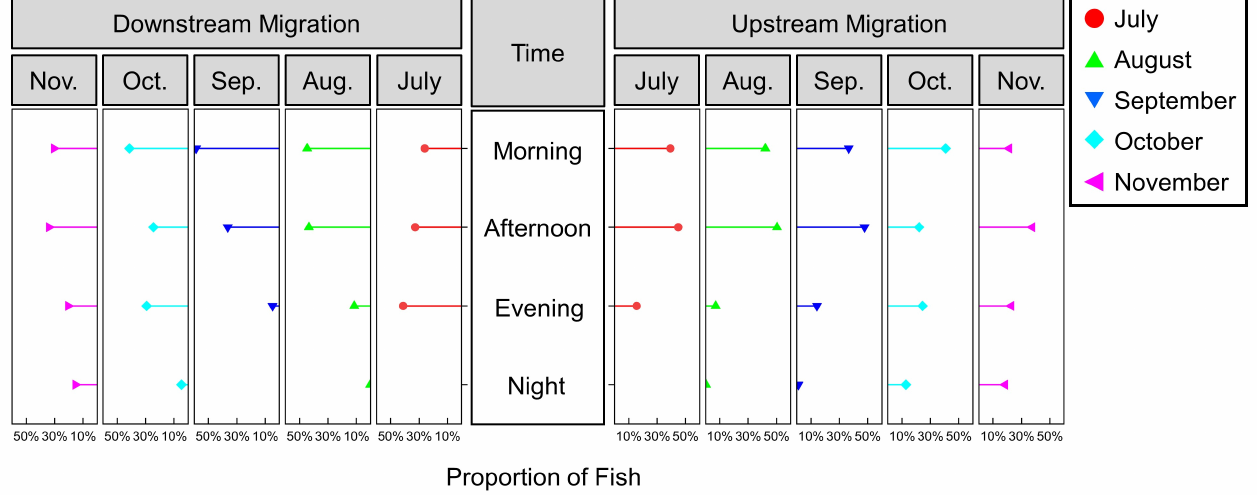
Figure 6. Circadian rhythms of upstream and downstream migration behaviors from July to